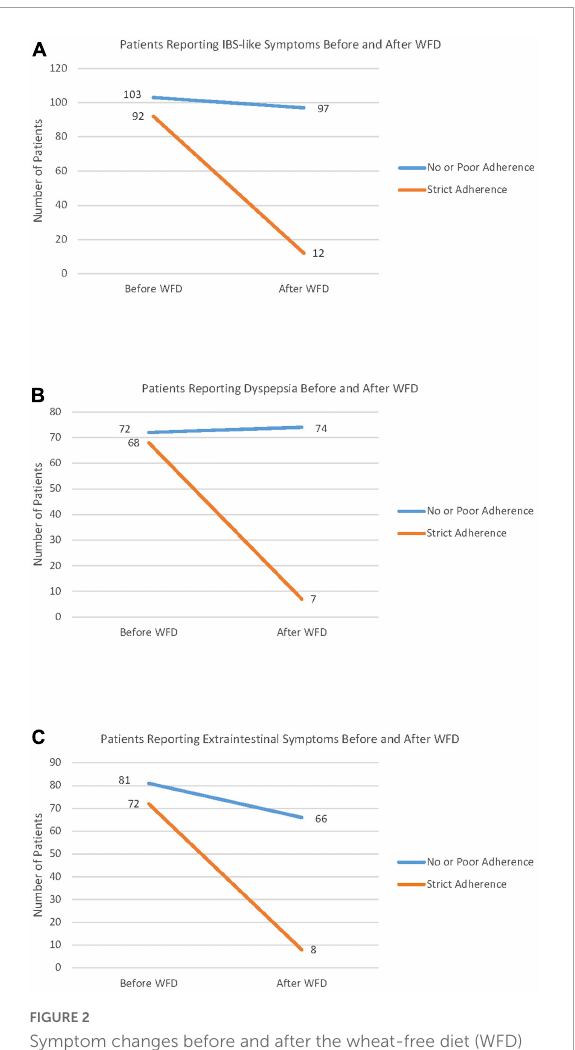
FIGURE2 Symptom changes before and after the wheat-free diet (WFD) according to a modern WFD adherence score. Patients with an adherence score between 0 and 2 were classified as non- or poorly adherent to the wheat-free diet. Patients with an adherence score of 3–4 were considered as strictly adherent to the diet. Panel (A) shows the number of patients reporting Irritable Bowel Syndrome-like (IBS) symptoms, before and after the WFD. Panel (B) shows the number of patients reporting dyspepsia, before and after WFD. Panel (C) shows the number of patients reporting extraintestinal symptoms, before and after